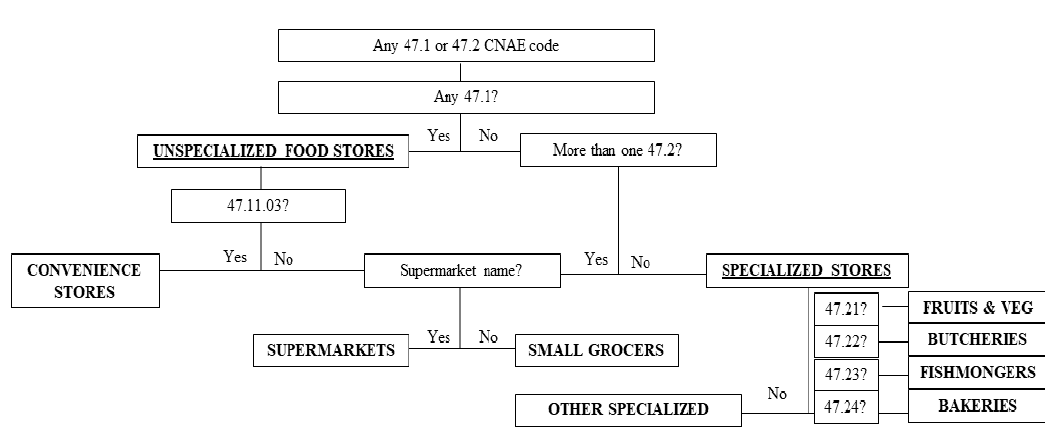
Figure 1. Classification algorithm used to classify food outlets based on a declared code of economic activity and outlet name. We used name recognition to differentiate supermarkets from small grocers, with a list of 60 supermarket names that we obtained from the Yellow Pages® [3].